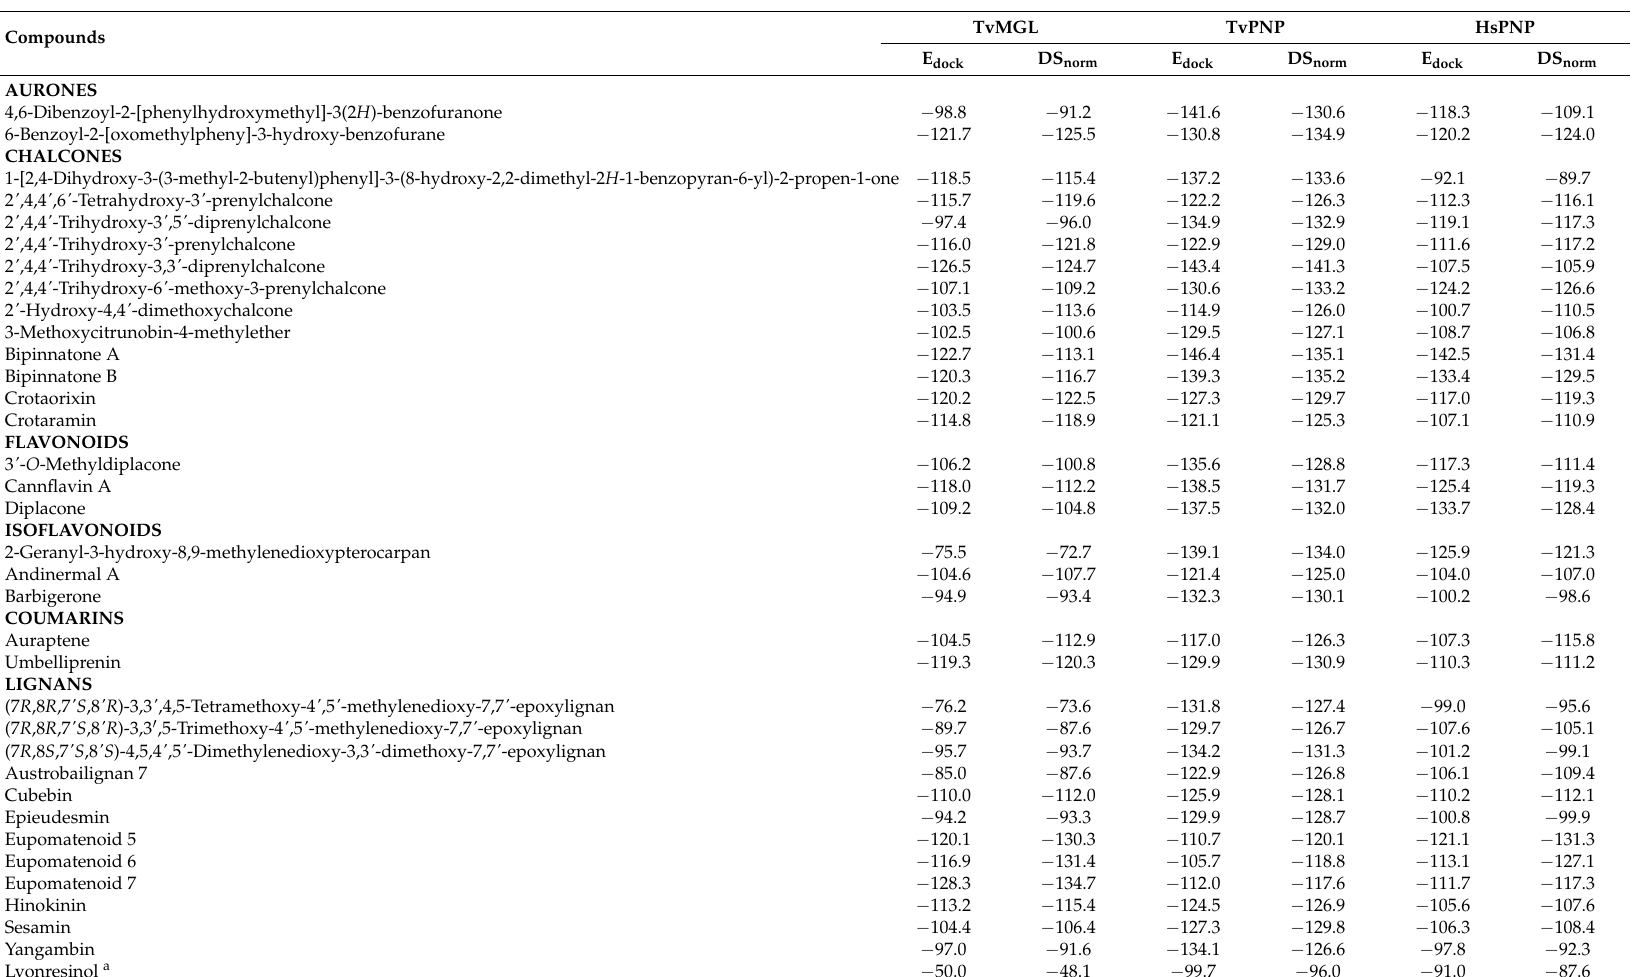
Table 5. MolDock (re-rank) docking scores and normalized docking scores (kJ/mol) for Trichomonas vaginalis methionine gamma-lyase (MGL) and T. vaginalis and human purine nucleoside phosphorylase (PNP).